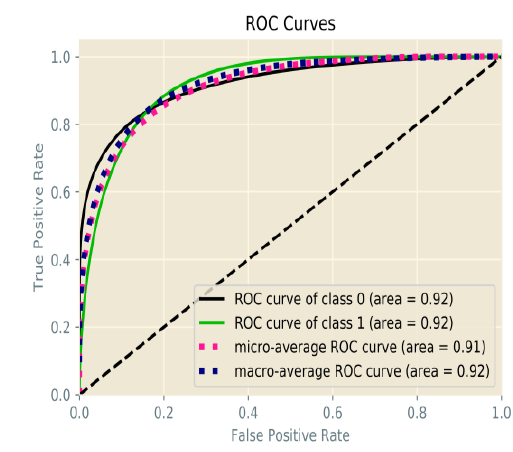
Figure 14. The Receiver Operating Characteristics (ROC) curve evaluation of the model.